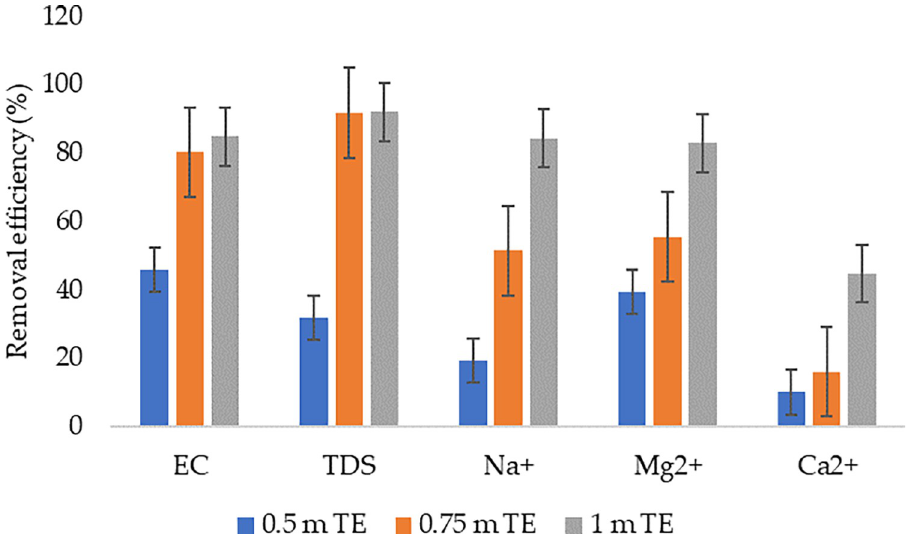
Fig 4. Removal efficiencies from the investigated column depths.